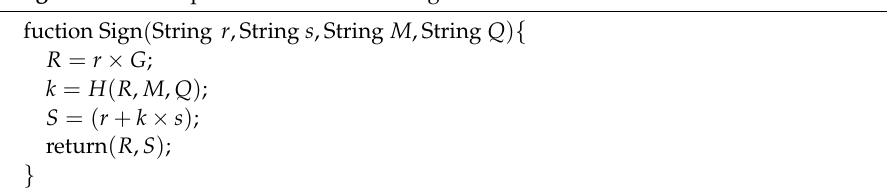
Algorithm 2: The process of the EdDSA signature between role A and role